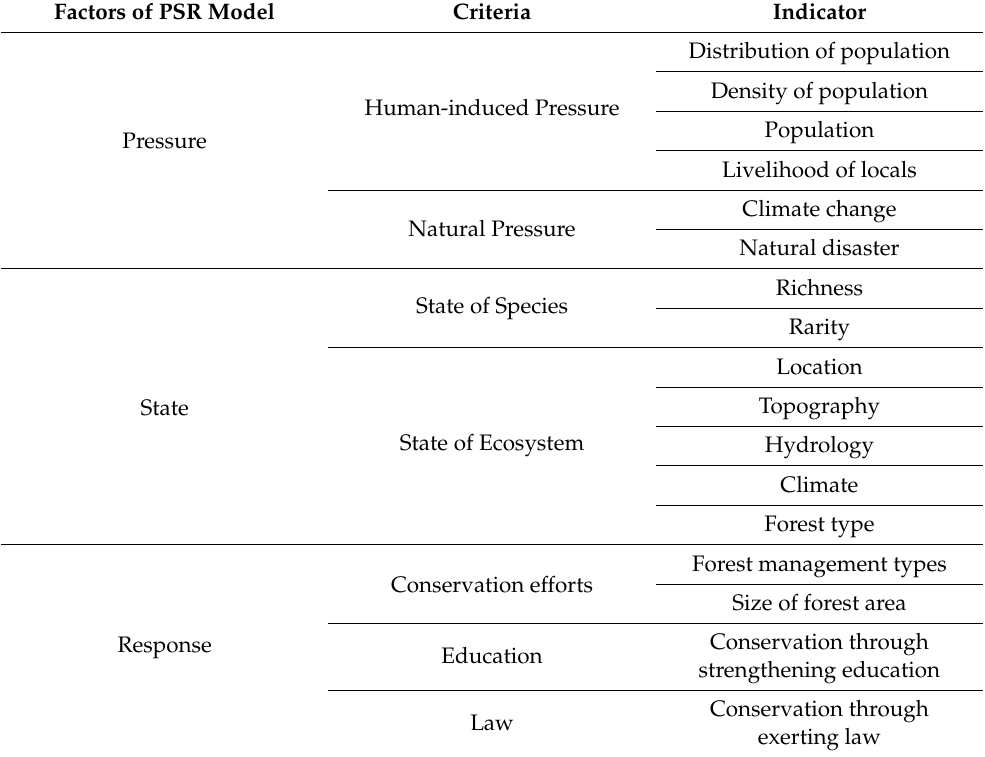
Table 3. Criteria and indicators for defining priority area for biodiversity